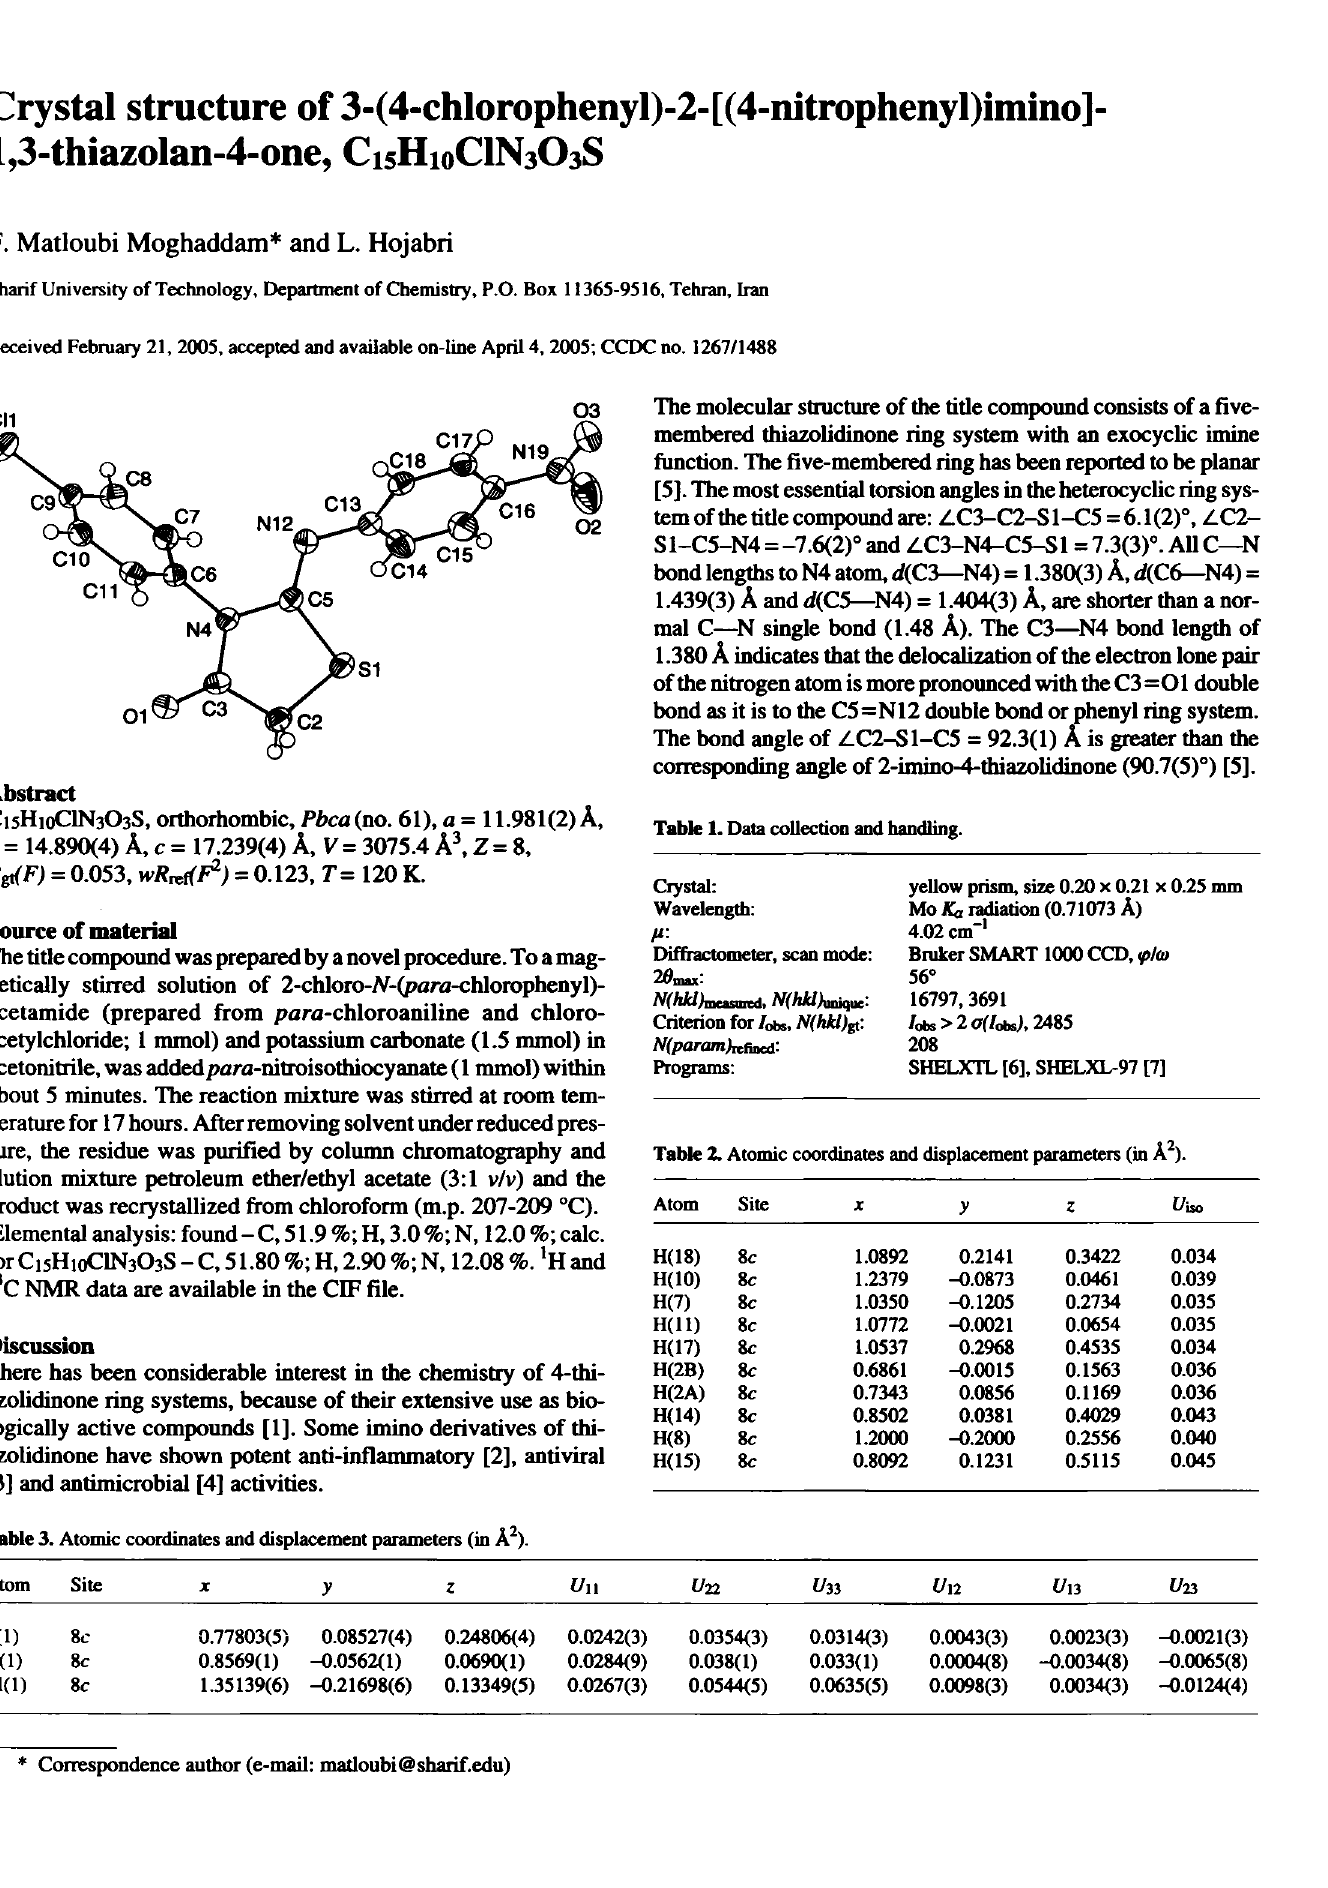
Table 3. Atomic coordinates and displacement parameters (in A 2